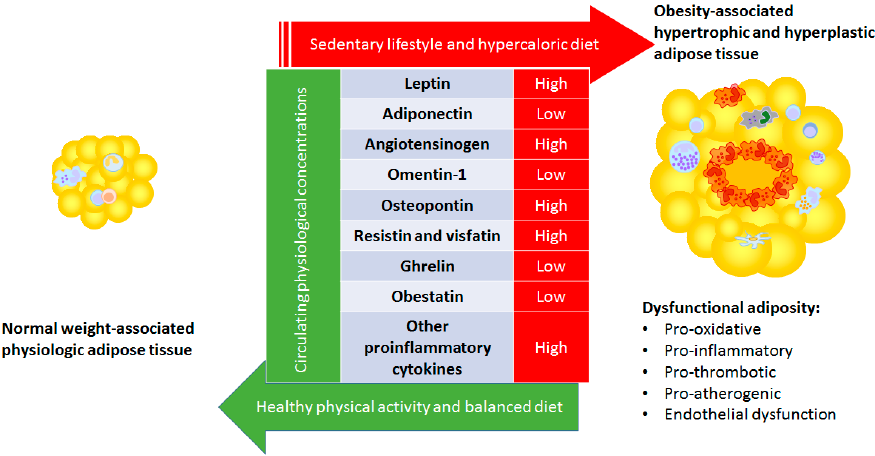
Figure 1. main changes observed in the dysfunctional adipose tissue ‐ derived